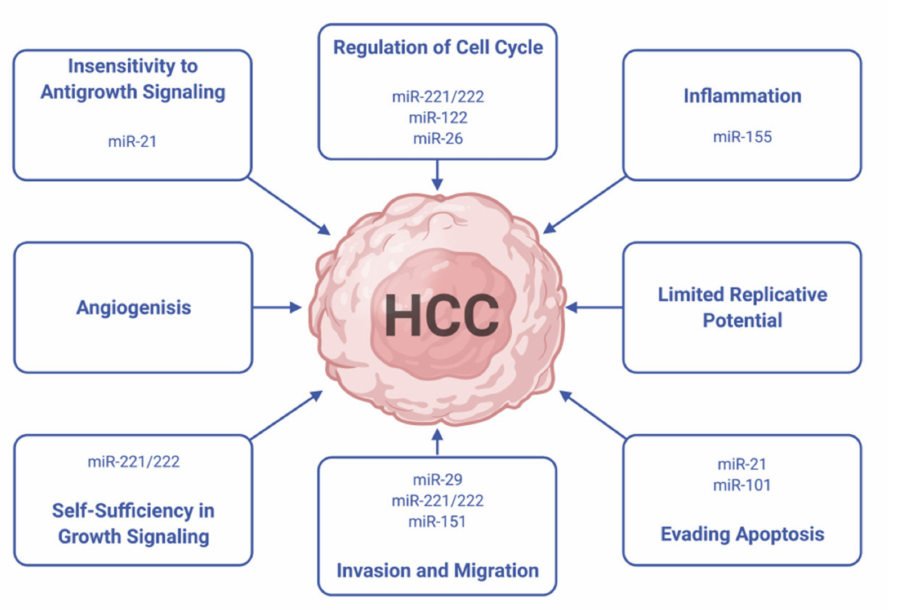
Figure 8. Several miRNAs act synergistically to promote HCC through the modulation of multiple cell phenotypes (Modified from